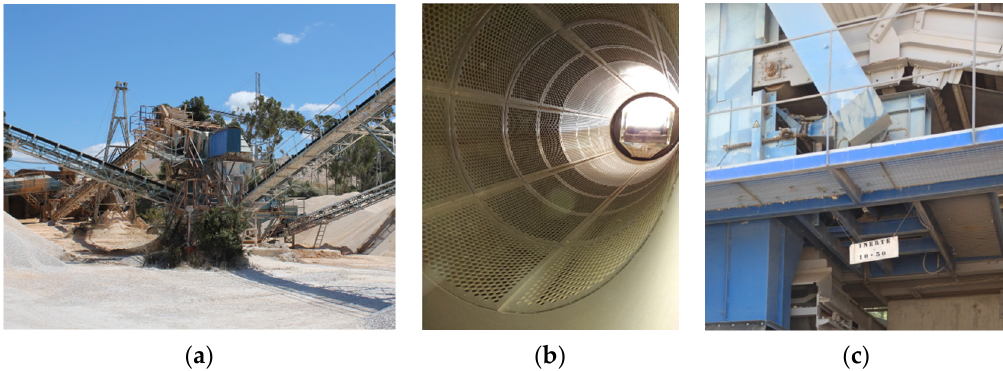
Figure 5. Crusher and magnetic separator( a ) Stationary screener (b) Trommel (c) Perforated belt conveyor.